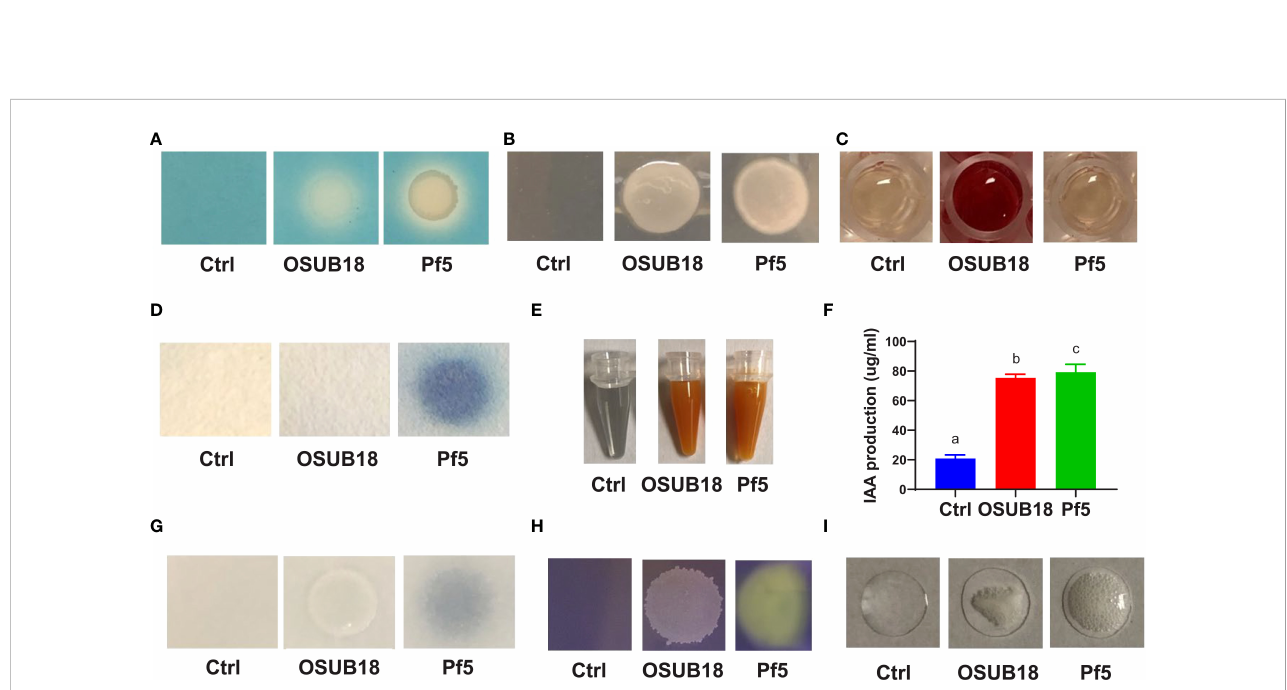
FIGURE 10 OSUB18 produced bene fi cial ISR-inducing metabolites suppressing plant pathogens and diseases and promoting plant growth. (A) Siderophore production. (B) Exopolysaccharide production. (C) Acetoin and diacetyl production. (D) HCN production. (E) Ammonia production. (F) IAA production. (G) Phosphate solubilization. (H) Organic acid production. (I) Catalase activity. The plant commensal bacterial Pseudomonas fl uorescens strain Pf-5 was used as a control. Data present mean ± SE of three biological replicates. Data with different letters indicate a p- value < 0.05 on ANOVA.